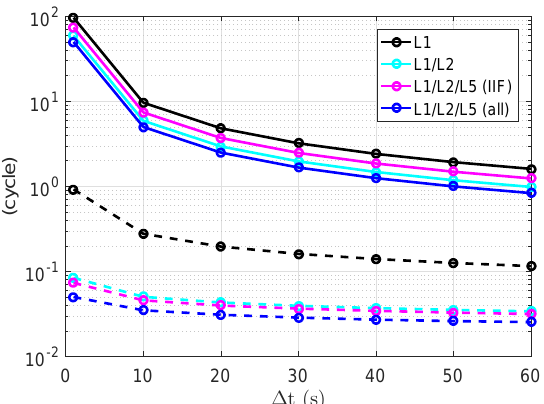
Figure 8. The terms ¯ σ ¯ a (Equation (25)) in solid lines and ¯ σ ¯ z (Equation (26)) in dashed lines. The satellite orbit on DOY 240, 2018, and the ground truth of baseline CUAA-CUBB were used for the plot.